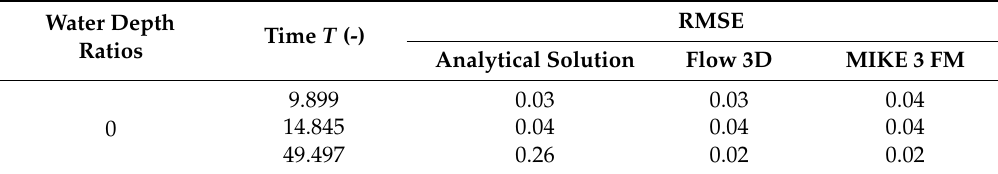
Table 2. RMSE values for the free surface profiles observed by Khankandi et al.